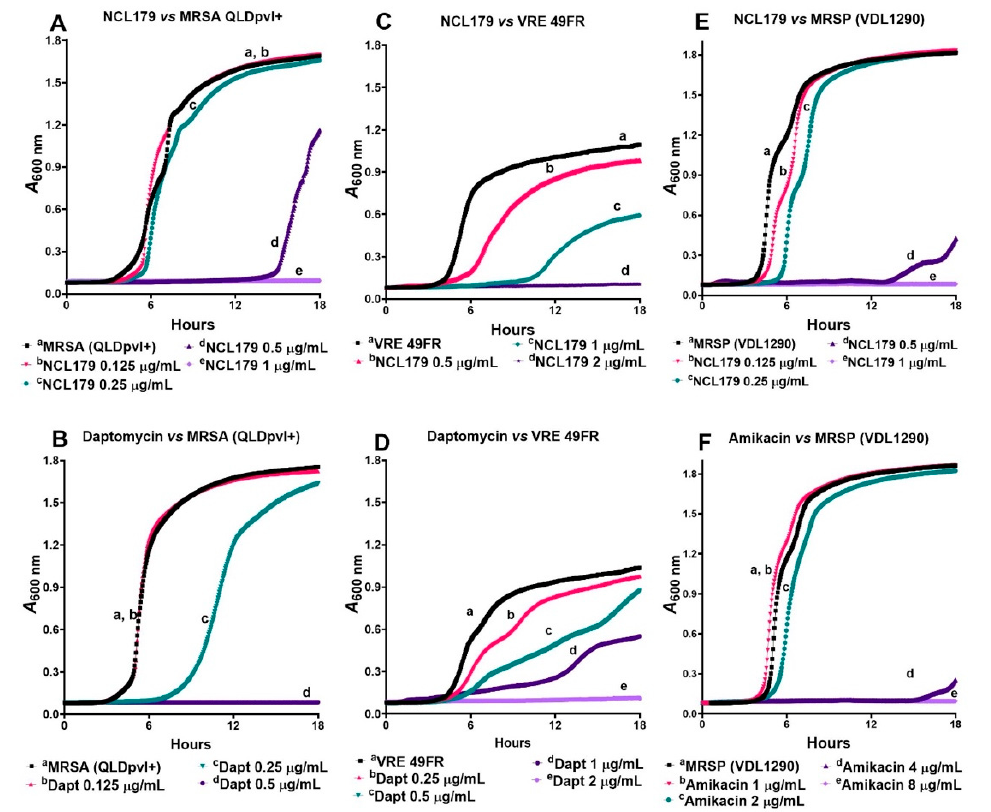
Figure 2. Time- and concentration-dependent kill kinetics of NCL179 against Gram-positive bacte- ria. ( A ), against MRSA QLDpvl+; ( C ), against VRE 49R; and ( E ), against MRSP (VDL1290) using daptomycin ( B , D ) and amikacin ( F ) as control drugs.